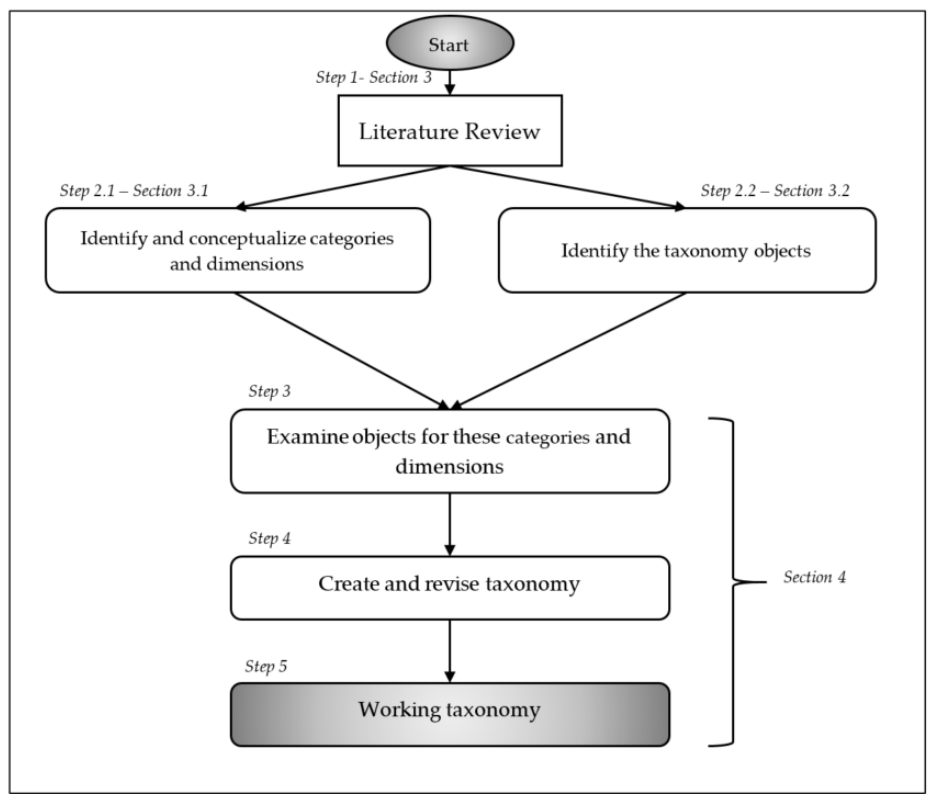
Figure 1. Research workflow.